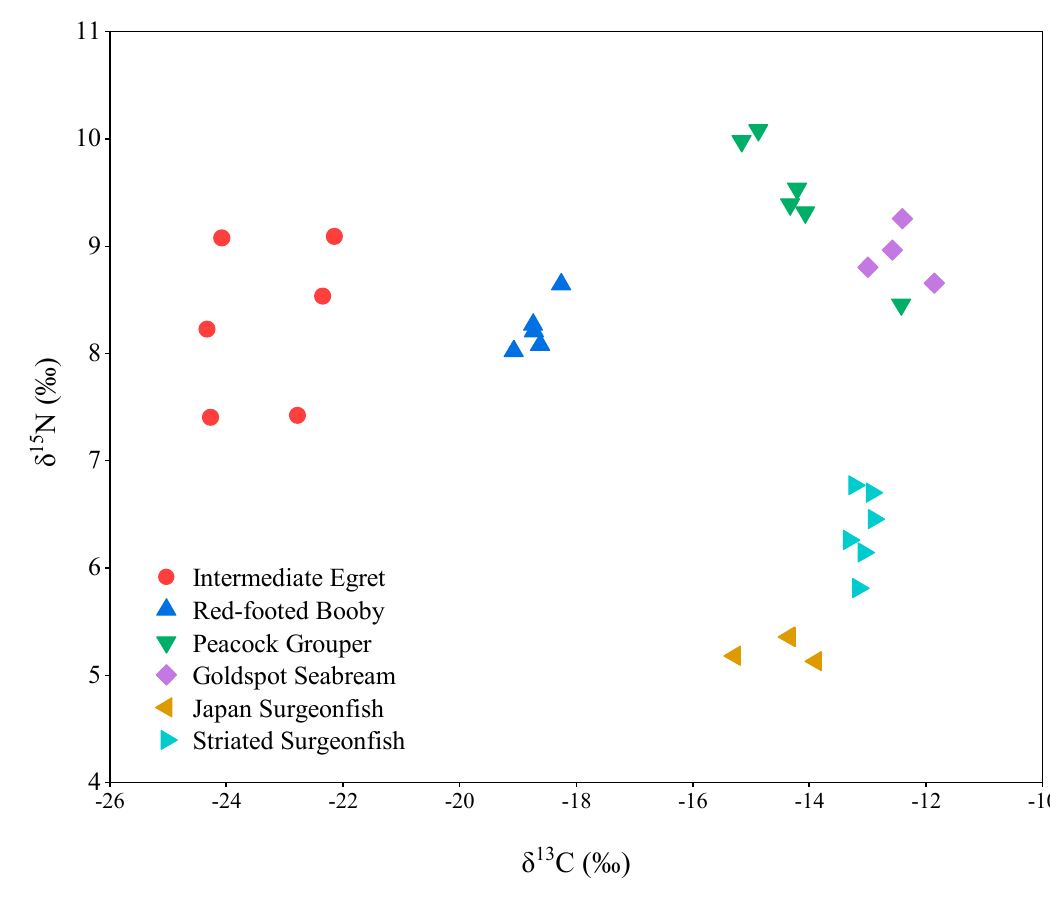
Figure 1. Stable isotope ratios of carbon and nitrogen in biota from Qilianyu Island.